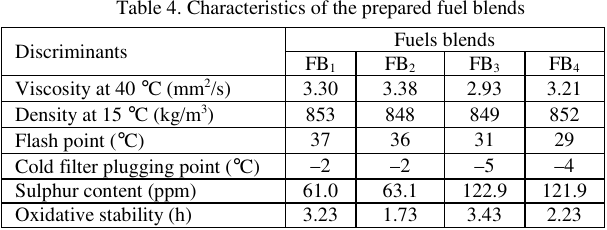
Table 4. Characteristics of the prepared fuel blends